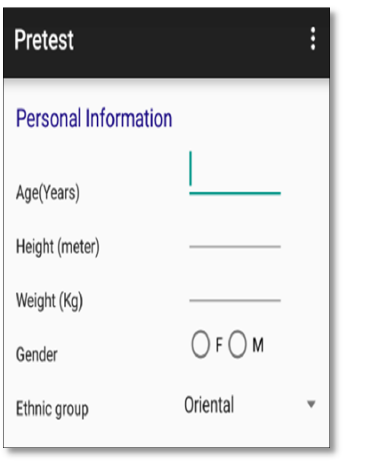
Figure 5. Pretest Activity Interface.